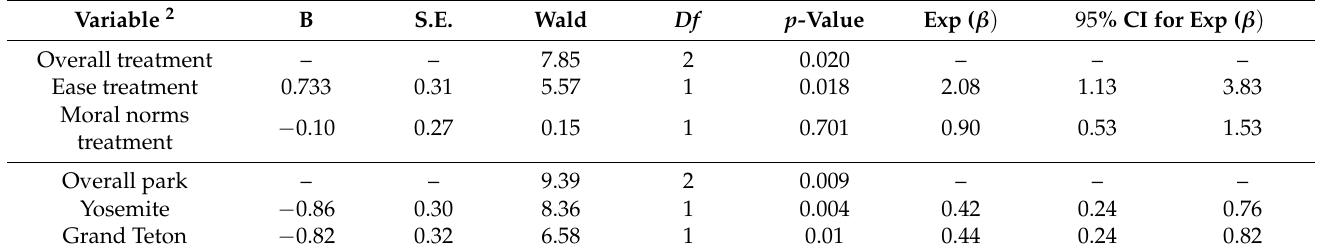
Table 6. Binary logistic regression model for proper disposal of waste with campground vistiors 1